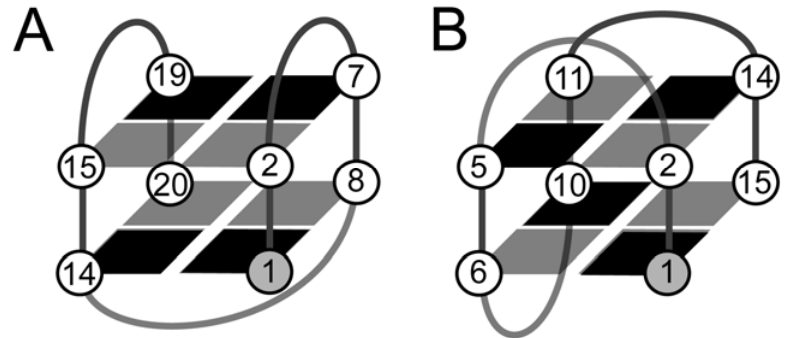
Figure 4. Schematic the two-stacked topologies defined by the ( A ) (-ld+l) loop progression; and ( B ) the (+l+l+l) loop progression. The dark shaded regions depict syn glycosidic bond angles and the light shaded anti glycosidic bond